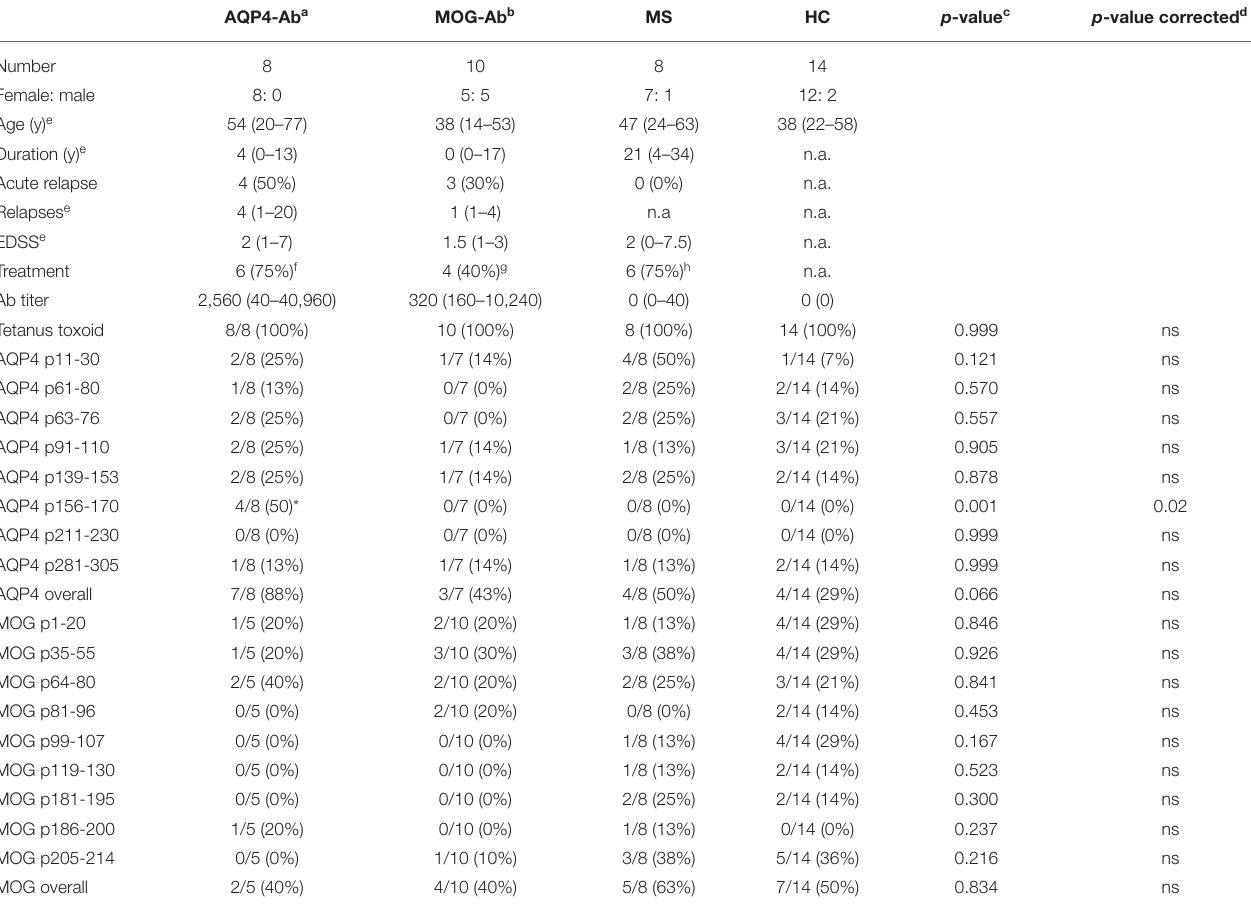
TABLE 1 | CD4 + T-cell proliferation with a cell division index ≥ 3 of T-cell cultures after stimulation with AQP4 or MOG